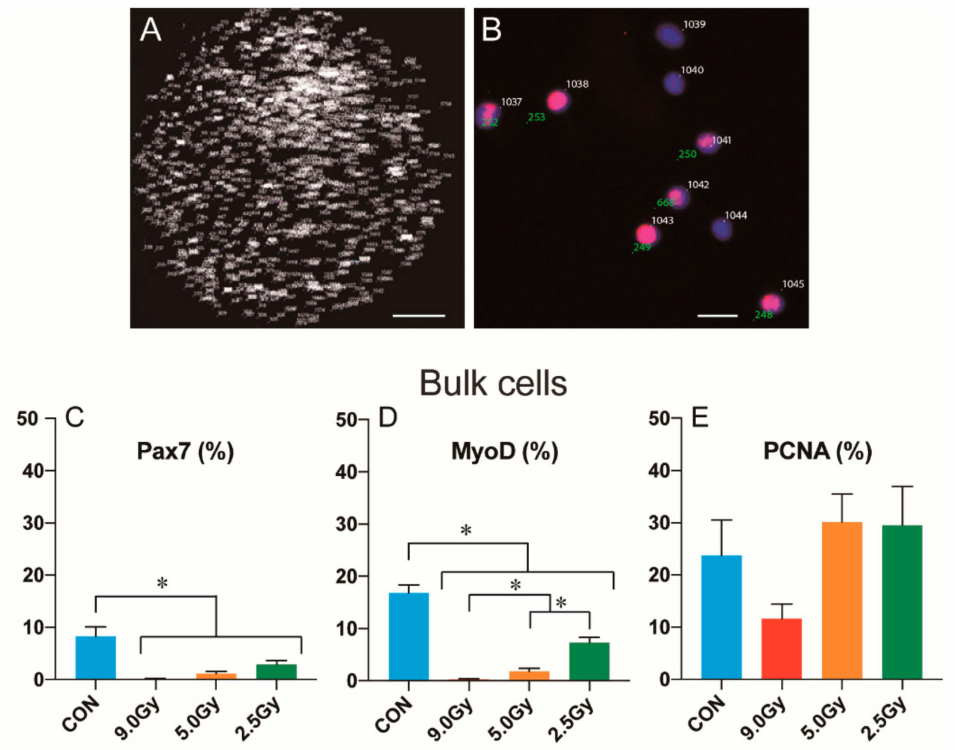
Figure 4. Quantitative analysis using immunocytochemistry. ( A ) Total cell count for bulk cells, depicted via a tiled image of high magnification (100 × ) photographs (64 pictures). Count numbers are provided next to the cells. Cell counting was used DAPI staining (blue staining, see panel ( B )), but this image is in black and white, due to the count number display. The scale bar represents 1 mm. ( B ) High-magnification image of MyoD+/ − cells, and identification of these counting. Pink staining is MyoD+ cells. The numbers entered in the upper right indicate the part of total cell count (white), and those on the lower left indicate MyoD+ cells (green). The scale bar represents 20 µ m. ( C ) The distribution ratio of Pax7+ cells in the bulk cells. ( D ) The distribution ratio of MyoD+ cells. ( E ) The distribution ratio of PCNA+ cells. Values were calculated as percentages of positive cells/total cells and expressed as mean ± SE. * p <